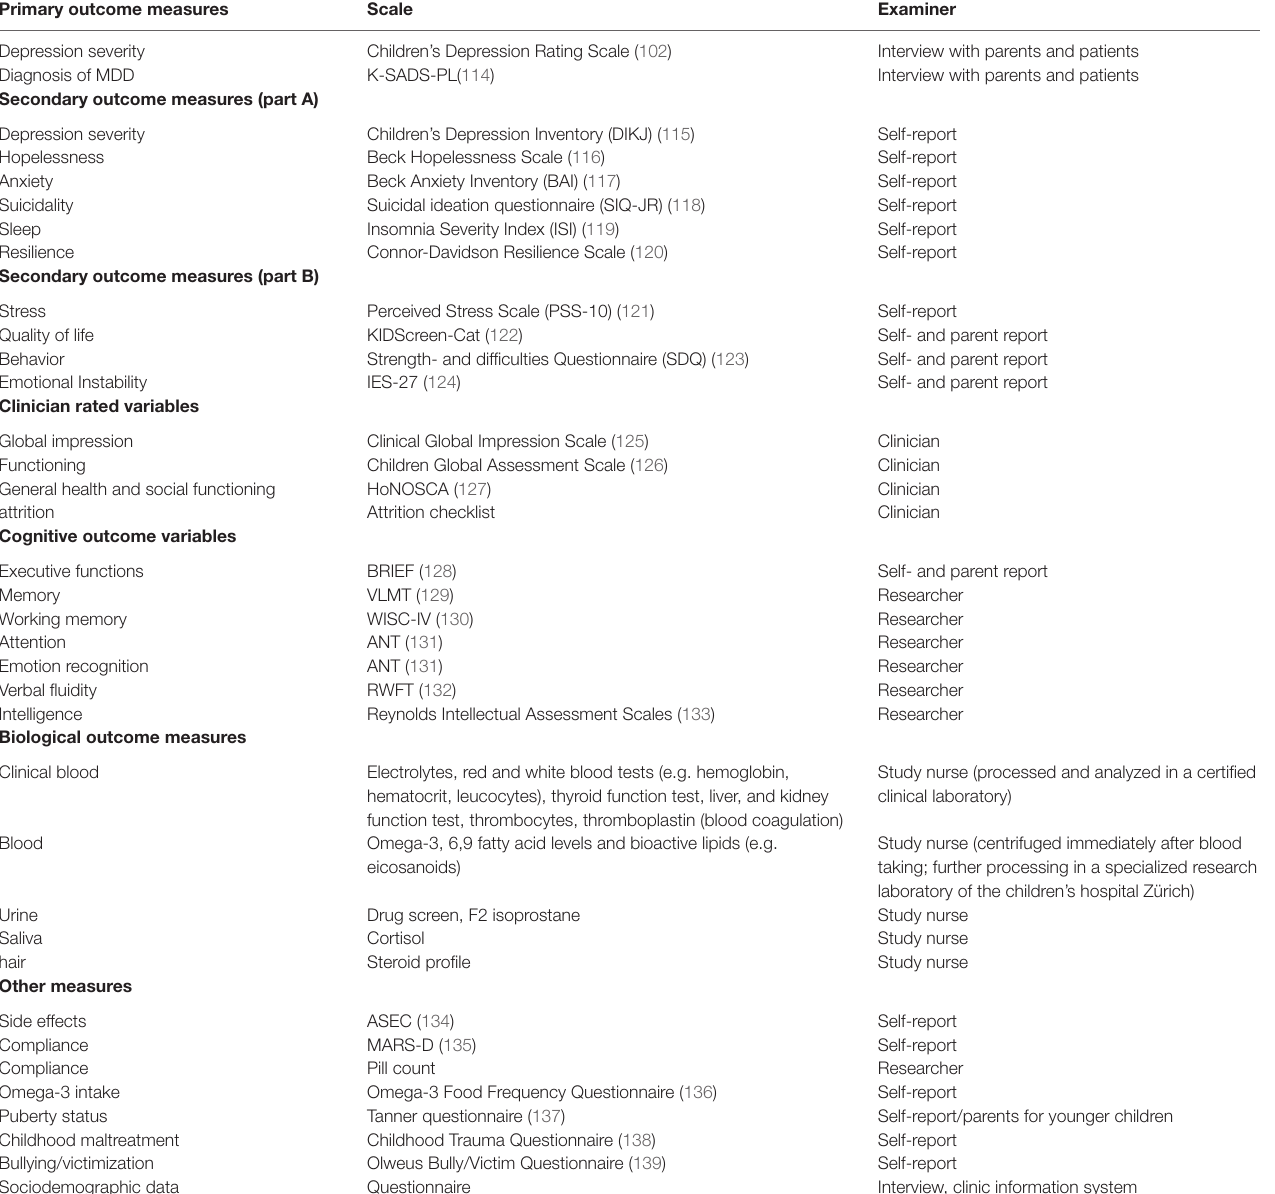
TABlE 2 | Outcome measures Omega-3-pMDD